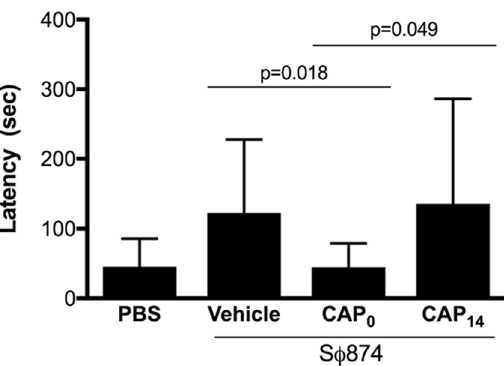
Figure 3. TRPV1 mediates depressive behavior associated with post-UTI chronic pain. UTIs were induced in female mice by transurethral instillation of E. coli strain S Φ 874 or saline (PBS, n = 13). S Φ 874 infected mice (n = 13) were administered 30 mg/kg capsazepine i.p. at PID 0 (CAP 0 , n = 13), at PID 14 (CAP 14 , n = 5), or treated with vehicle at PID 0 (n = 13). Mice were then assessed for depressive behavior by quantifying feeding latency in novelty-supressed feeding assay at PID 15. S Φ 874-infected mice receiving vehicle exhibited significantly increased latency (P < 0.05) relative to saline-treated mice that was prevented in mice receiving capsazepine administered at PID 0 but not altered by capsazepine administered at PID 14. Values represent mean ±